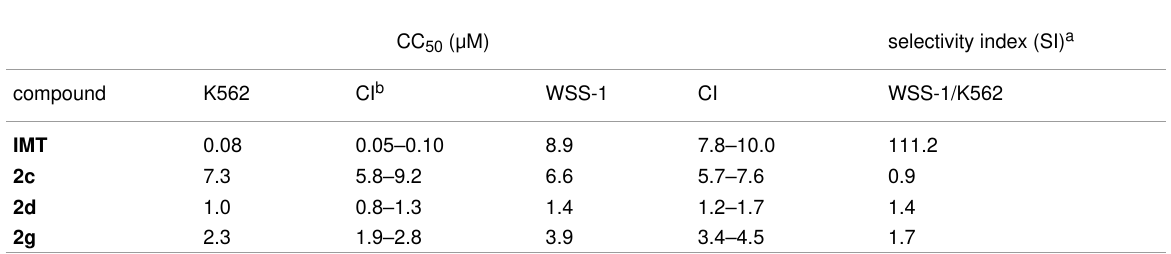
Table 1: Cytotoxic activity, confidence interval, and selectivity index of imatinib and derivatives 2c , 2d , and 2g against K562 and WSS-1 cell lines.